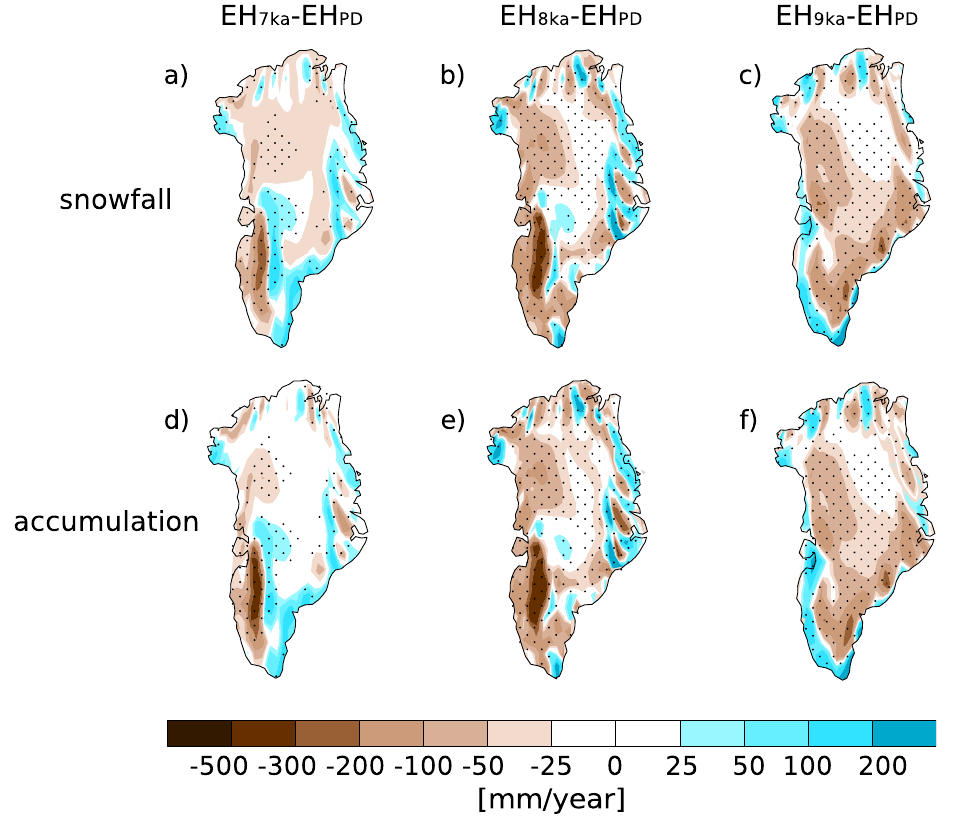
Fig. 5. Early Holocene ice sheet sensitivity of annual mean (a, b, c) snowfall and (d, e, f) accumulation [mmyr − 1 ] for the simulations with 7, 8, and 9ka ice sheet topography. All values are anomalies from the basic early Holocene simulation (EH PD ) with the present-day Greenland Ice Sheet. Stippling denotes values significant at the 5% level based on t -test